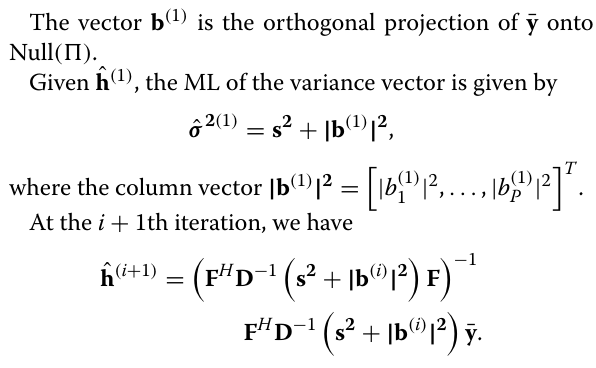
ˆ h ( i + 1 ) , the ML of the variance vector is given by Given ˆ σ 2 ( i + 1 ) = s 2 + | b ( i + 1 ) | 2